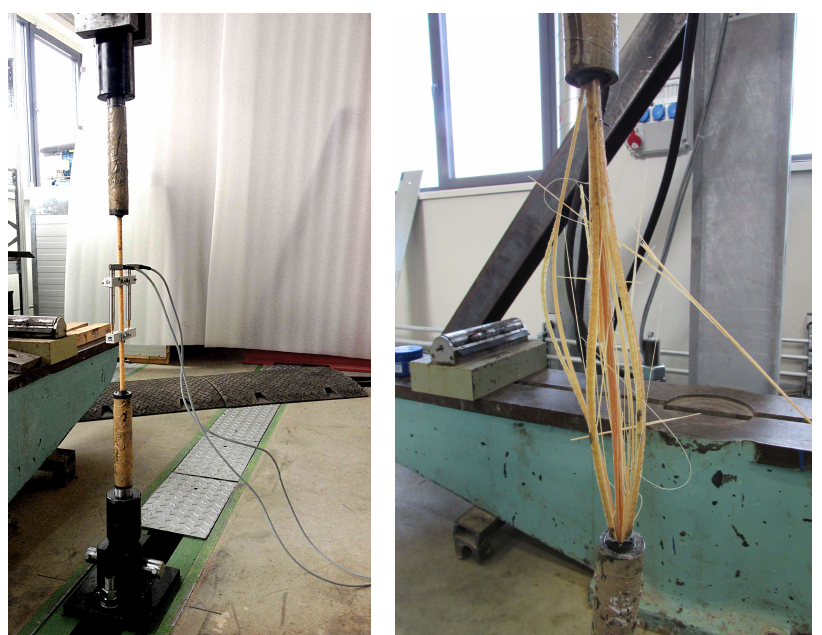
Figure 4. Cyclic test configuration with LVDTs (left), broom-like failure mode with an undamaged core (right).